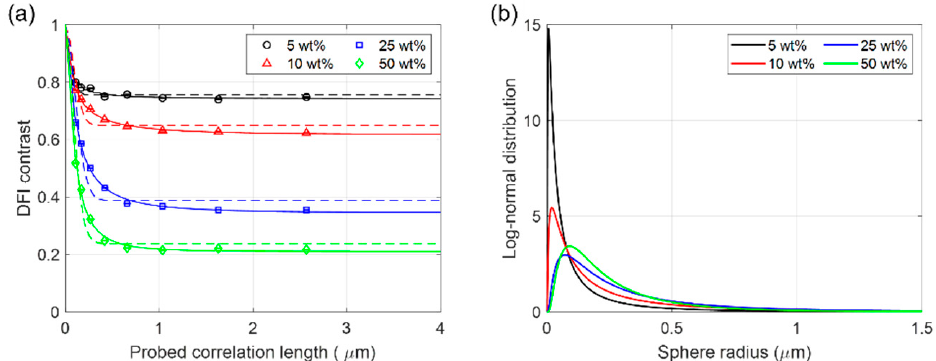
Figure 5. ( a ) Dark-field image (DFI) contrast of the diluted milk over probed correlation length. The solid lines represent fits by projected real-space correlation functions of the polydisperse interacting hard-sphere model for fat globules (FG), and the dashed lines represent the results of simple isolated monodisperse hard-sphere model. ( b ) The log-normal size distribution of the polydisperse FG modelled for the different deuterated milk samples. (Color in online). Table 2. Structural parameters and goodness of fits for fat globules (FG) in the deuterated milk samples with different fat contents derived using the simple isolated monodisperse hard-sphere model.